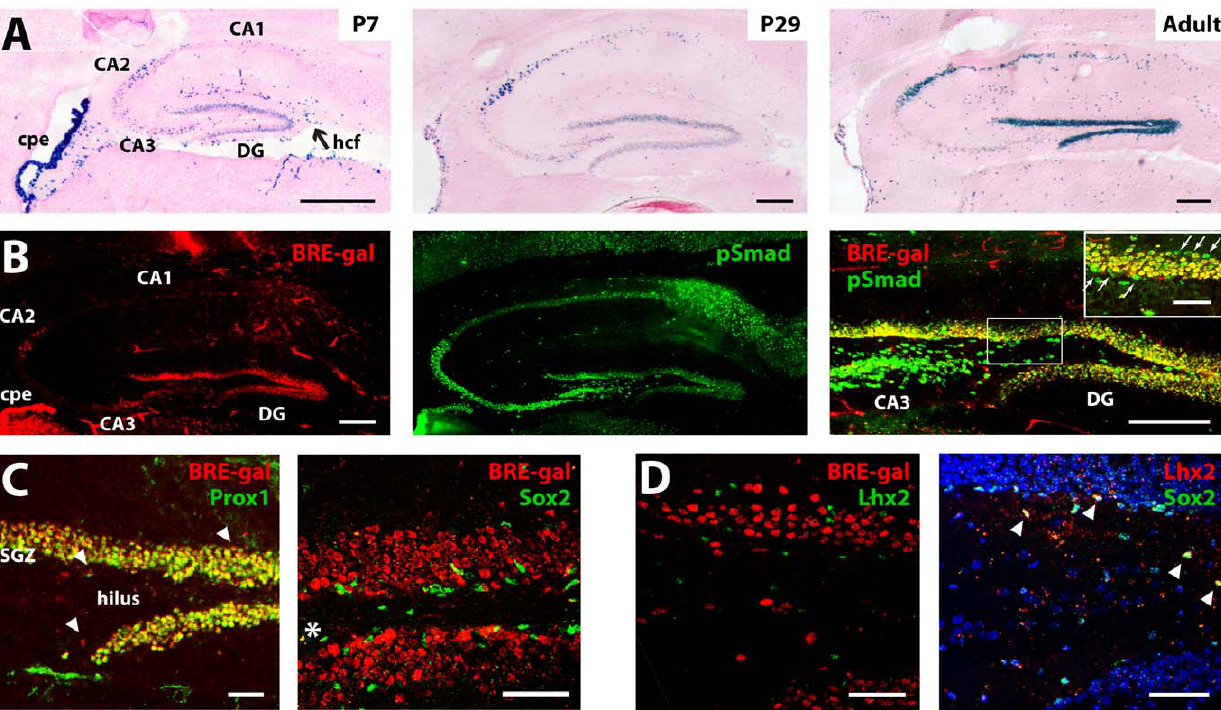
Figure 3. BRE-gal induction in the postnatal hippocampus. ( A ) Xgal stains of P7, P29, and adult (10 months) sagittal sections, with eosin counterstain. Although BRE-gal is absent from the hippocampal anlagen before E17.5 (Figs. 1, S1A), BRE-gal expression becomes detectable in the dentate gyrus (DG) and cornu ammonis 2 (CA2) field by P7. Expression in these regions then becomes strong and stable in adults. ( B ) pSmad/BRE-gal IHC of adult sagittal sections. Like BRE-gal, pSmad is expressed in the DG and CA2 regions, but is also expressed in CA3 and CA1. In the DG, virtually all BRE-gal-expressing cells also label for pSmad (right panel). However, some pSmad-positive cells in subgranular and supragranular zones of the DG are BRE-gal-negative (inset; arrows). ( C ) IHC of adult sagittal sections, confocal images. Nearly all Prox1-expressing DG granule neurons are BRE-gal positive. A few BRE-gal + /Prox1- cells are also observed (arrowheads). BRE-gal is not expressed by Sox2-positive neural stem cells of the subgranular zone (SGZ), although coexpression is seen in some hilar cells (asterisk). ( D ) IHC of adult sagittal sections, confocal images. Lhx2 is expressed in a subset of Sox2-positive neural stem cells (arrowheads in right panel), but not in BRE-gal-positive granule neurons. Scale bars: 200 um (A,B), 50 um (inset in B,C,D). Abbr: DG, dentate gyrus; CA, cornu ammonis; cpe, choroid plexus epithelium; hcf, hippocampal